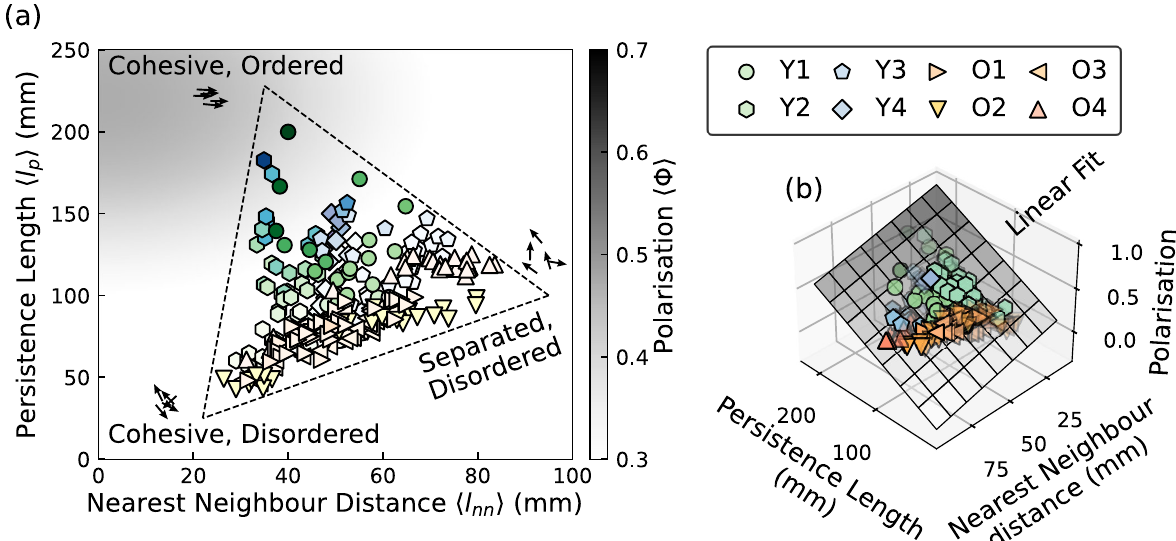
Fig 3. The states of Zebrafish characterised by two length scales. A: The states of the fish represented by the nearest neighbour distance and the persistence length. The brightness of the markers corresponds to the value of the polarisation. Each scatter–point corresponds to a time-average of 2 minutes. Different shapes indicate different fish groups from different experiments. B: A multilinear regression model fitting the relationship between the polarisation and the two length scales, indicating the polarisation increase with the increase of persistence length, and the decrease of the nearest neighbour distance. The model is rendered as a 2D plane, whose darkness indicates the value of polarisation.